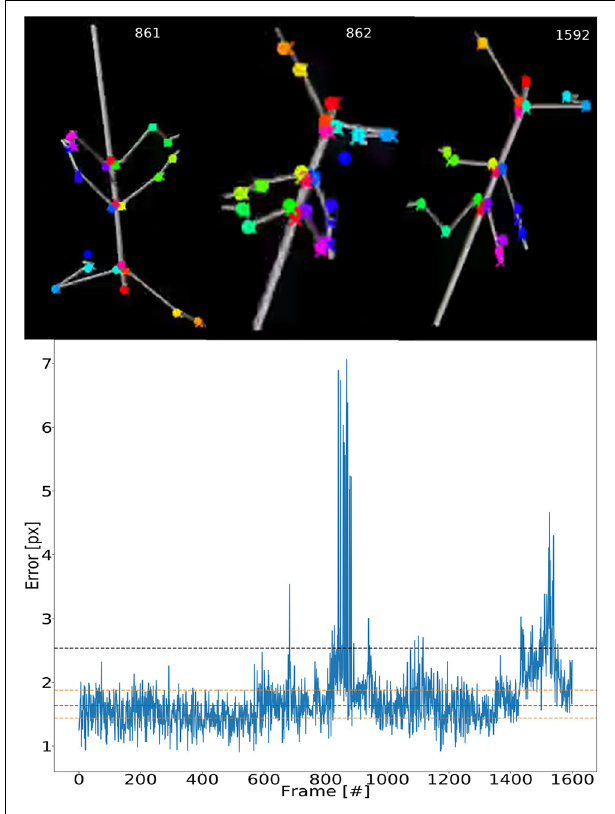
FIGURE 5 | Test error is equally low for most frames. Median pixel errors of all body features were included. The model was trained on video comprising frames with five scaling factors and eight rotations (RS, as in Figure 4 ). The pixel error varies around a common mean for most video–episodes with three peak regions beyond 3.0 at frames 670, 800–900 and 1,500. These peaks correspond to “difficult postures.” The dashed red line represents the median and the two yellow lines are the first and third quartiles. The black line represents the 1.5 times the interquartile range. The top row shows selected frames from difficult regions. Colored points label the features